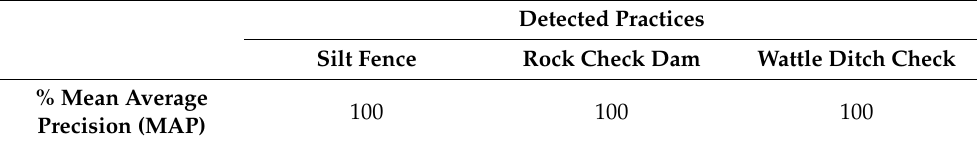
Table 1. Mean average precision (MAP) values for detected practices.